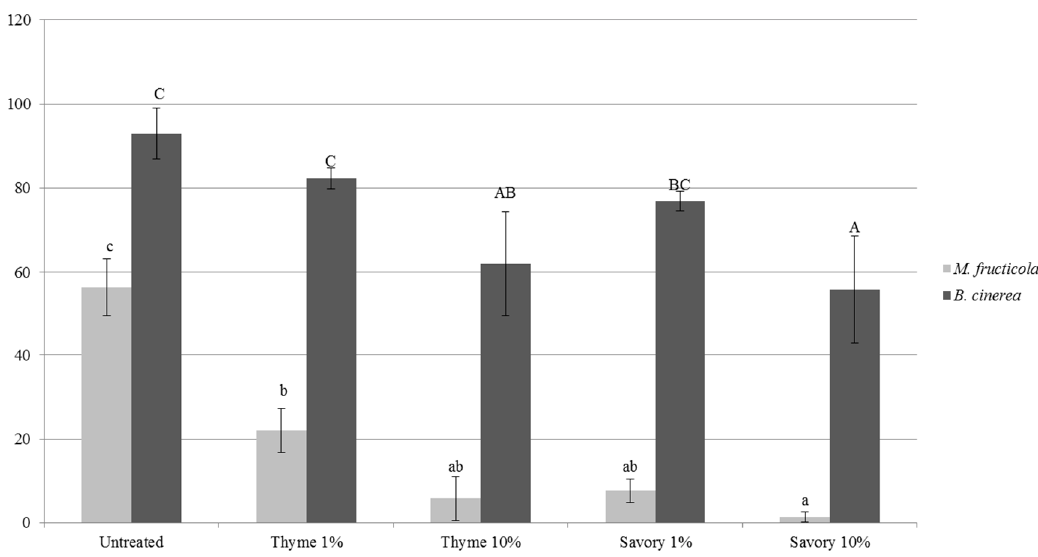
Figure 2. M. fructicola (gray columns) and B. cinerea conidial germination percentage (black columns) after biofumigation without direct contact with essential oil in vitro. Conidial germination was assessed after 20 h for B. cinerea and 36 h for M. fructicola at 20 °C. Values of the same pathogen, followed by the same letter, are not statistically different by Tukey’s Test ( p < 0.05).